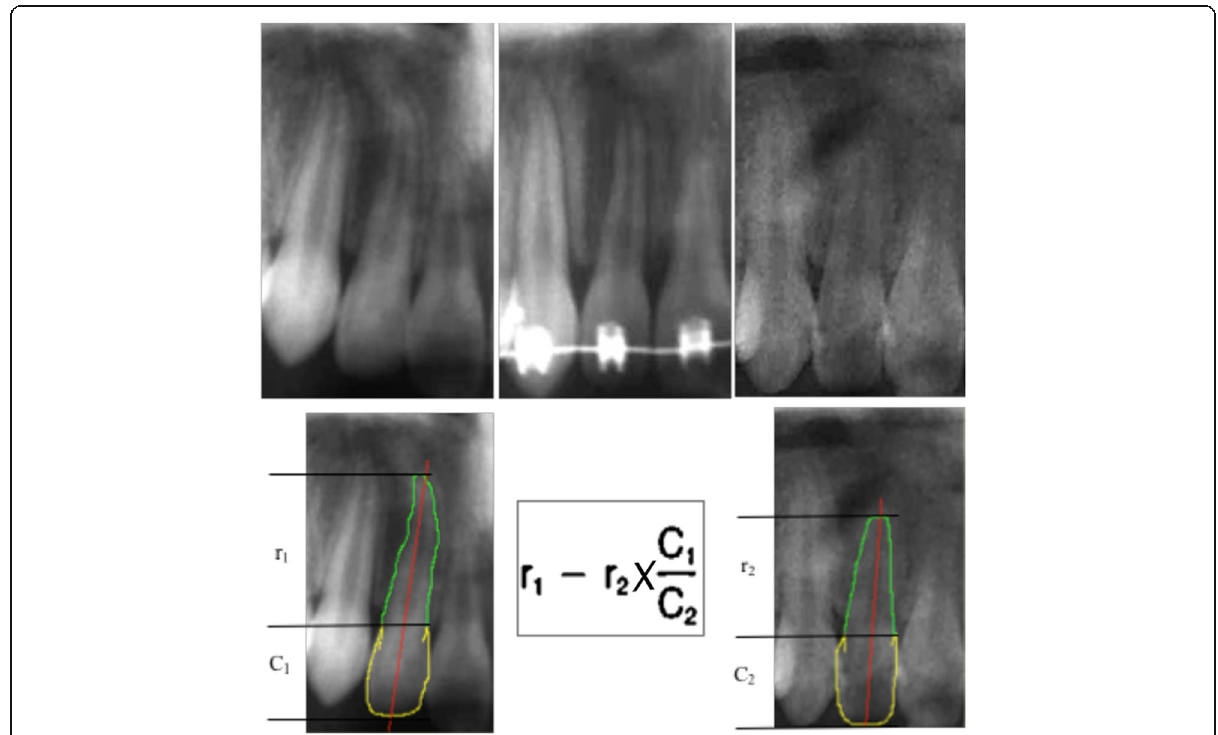
Fig. 2 Cropped OPG of a participant exhibiting moderate OIIRR of tooth No. 12 with equation used to assess the degree of OIIRR